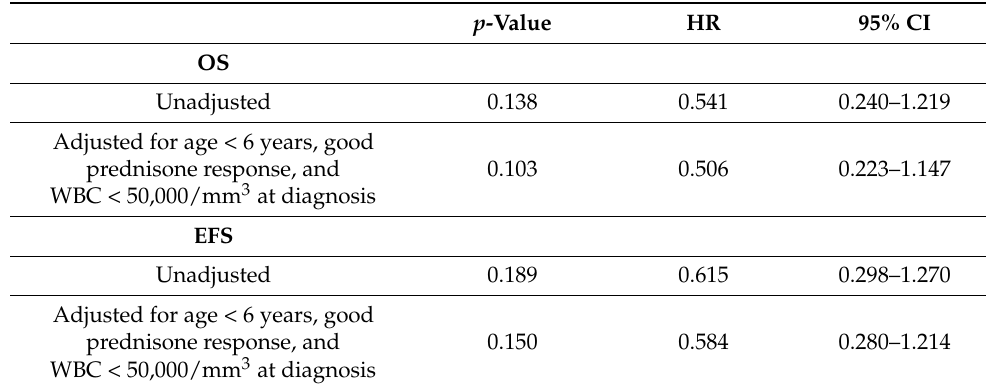
Table 4. Multivariate Cox regression analysis of the impact of asparaginase hypersensitivity on outcome.